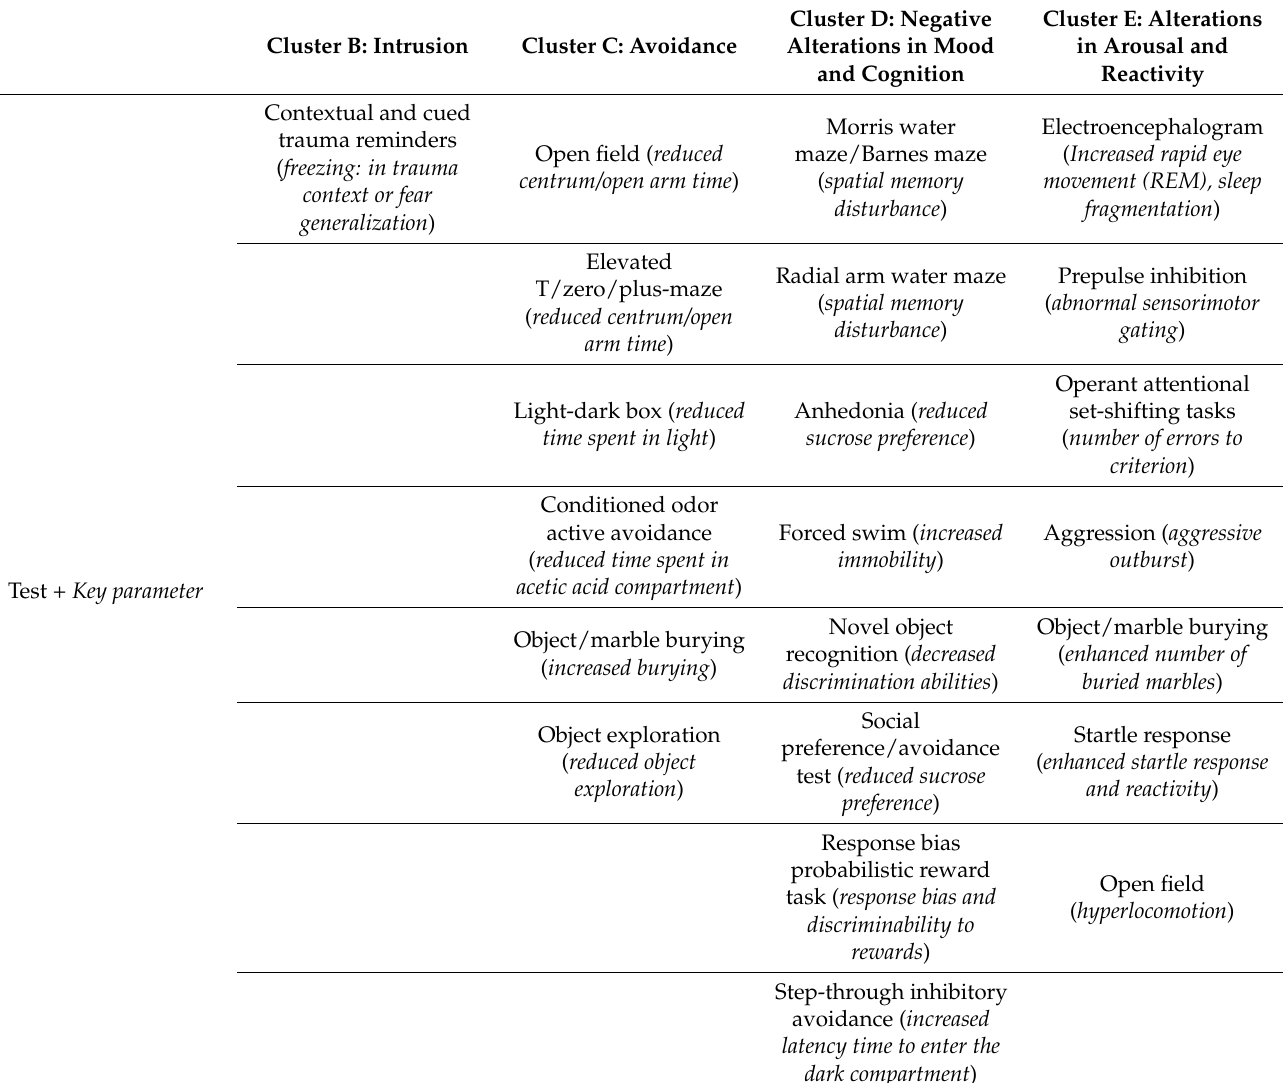
Table 2. Summary of tests used in animal models of